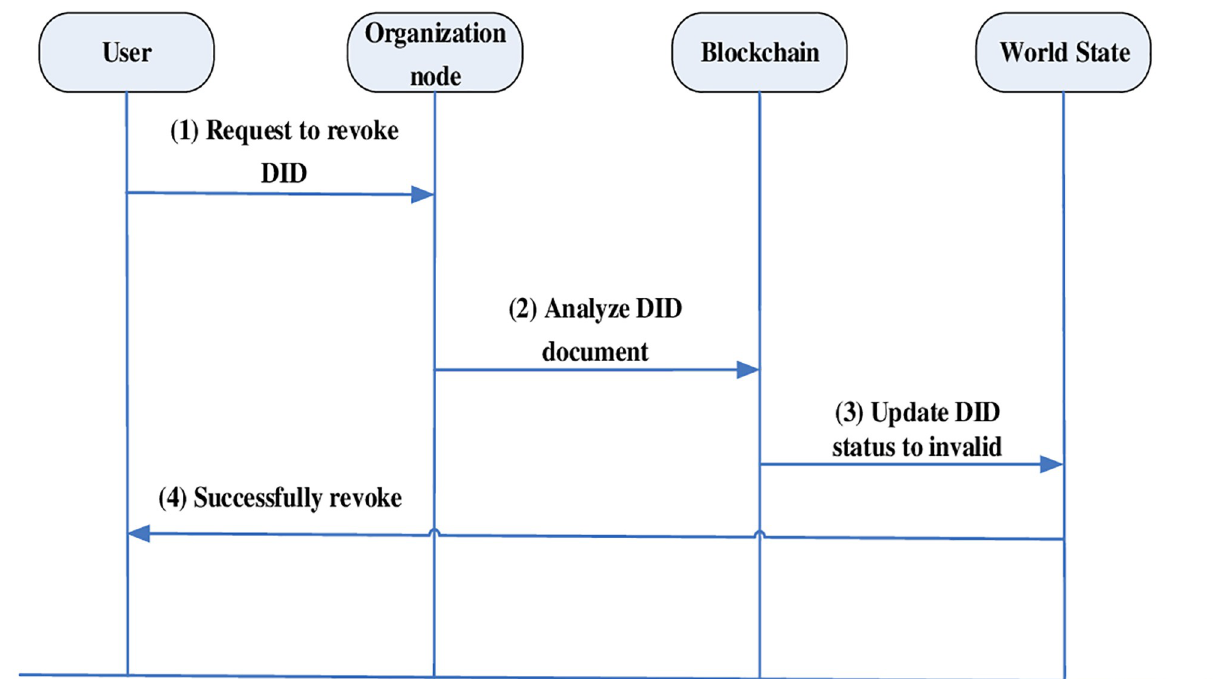
Fig 10. DID revocation process.